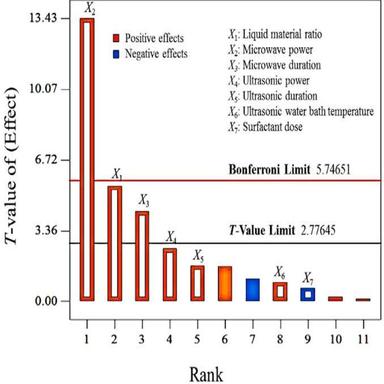
Pareto chart of effects of seven variables.